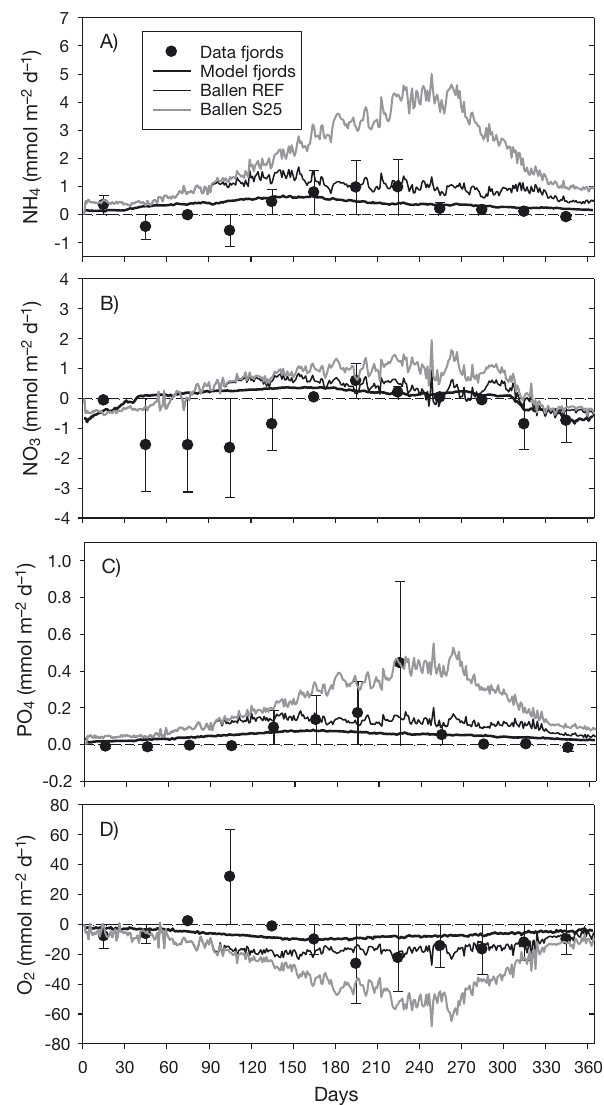
Fig. 6. Comparison of sediment−water fluxes of (A) NH 4 , (B) NO 3 , (C) PO 4 and (D) O 2 between monitoring data (monthly average ± SD) for 1999, 2000 and 2003 with severe hypoxia and model data (2009) from 6 shallow stations in Horsens Fjord and Odense Fjord. Results from Ballen reference run (REF) and Scenario 25 (S25) are also shown. Positive fluxes indicate release, and negative fluxes indicate uptake